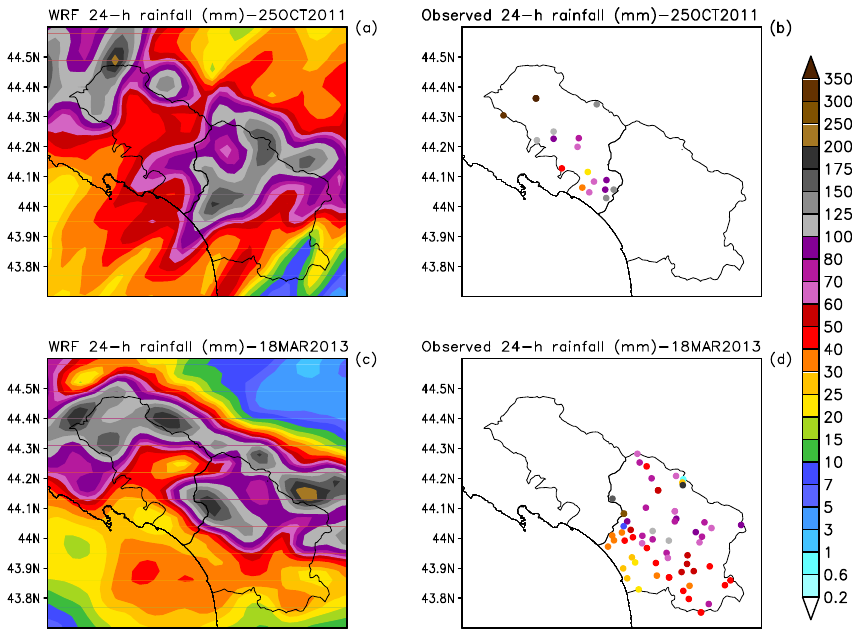
Figure 4. (a) , (b) Modelled and observed precipitation in mm accumulated in the 24h period starting at 00:00UTC of 25 October 2011. (c) , (d) Modelled and observed precipitation in mm accumulated in the 24h period starting at 00:00UTC of 18 March